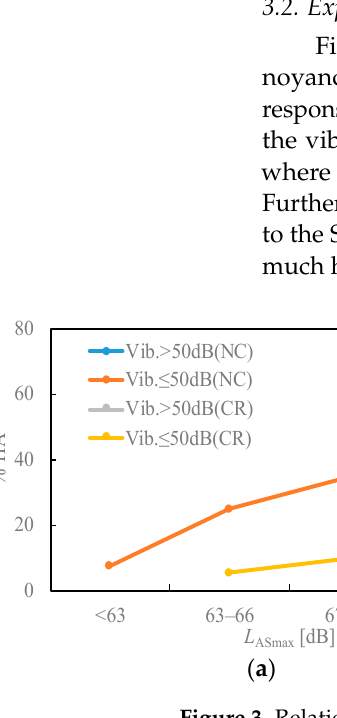
( b ) Figure 4. Relationships between noise exposure level and self-reported sleep disturbances. ( a ) Falling asleep; ( b ) awaken- ing.